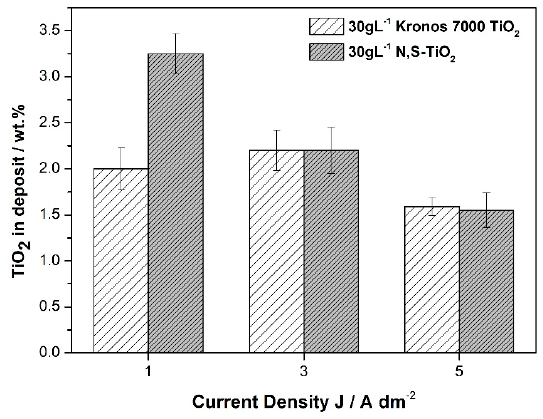
Figure 7. Weight percentage of commercial Kronos and N,S-TiO 2 particles, immobilized within the alloy matrix at 30 g·L − 1 TiO 2 loadings as a function of applied current density values.